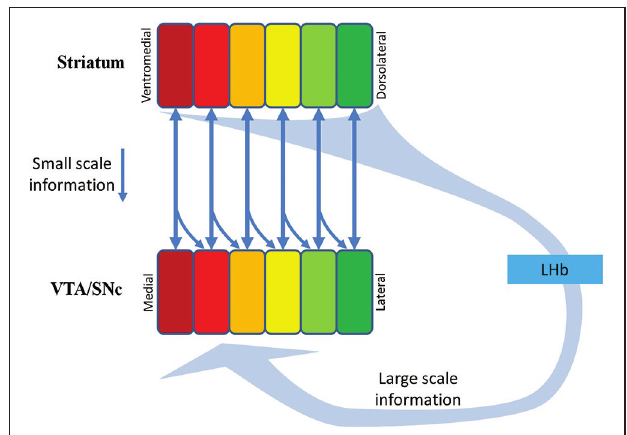
FIGURE 3 | Multiple-scale feedback inputs from the NPs in the striatum . DA neurons in the VTA/SNc receive small-scale feedback information from their target NPs (the vertical downward arrows), and large-scale feedback information via the striatum → GPb → LHb → RMTg → DA projection. The scope of the pan-in-pan-out of the large scale information is unknown. The squares in Striatum indicate parallel NPs. The squares in VTA/SNc indicate functional groups of DA neurons supplying DA inputs to the counterpart NPs. SNc, Substantia nigra compcata; GPb, globus pallidus border neurons; LHb, lateral habenula; RMTg, rostromedial tegmental nucleus.